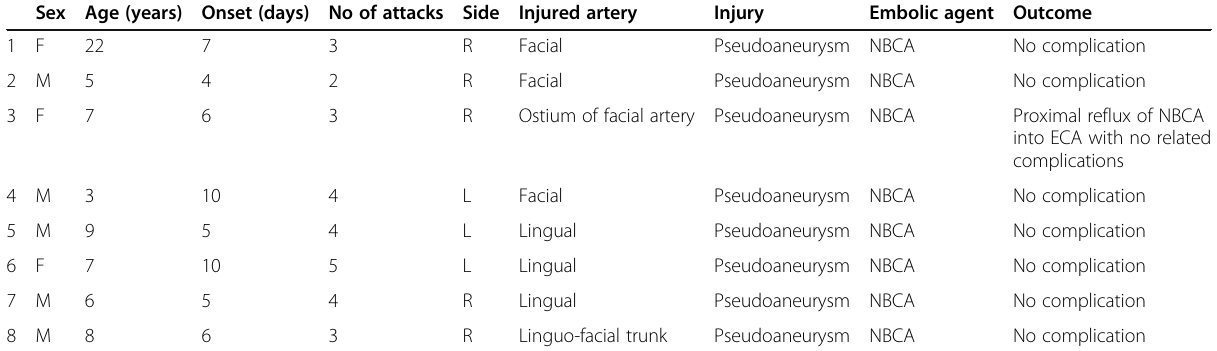
Table 1 Demographic data and results Sex Age (years) Onset (days) No of attacks Side Injured artery